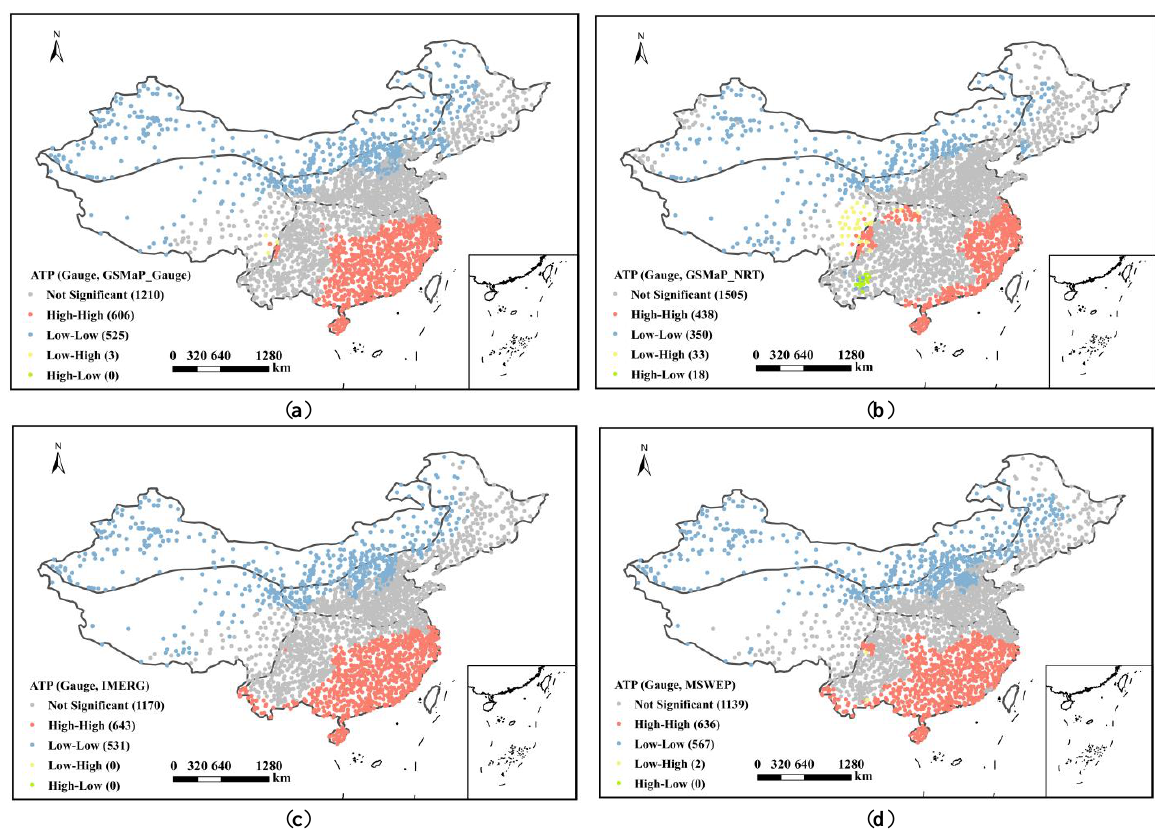
Figure 21. The LISA cluster maps of Box-cox transferred ATP between the gauge observations and the four SPPs and the number in the bracket represent the corresponding number of gauges: ( a ) GSMaP_Gauge, ( b ) GSMaP_NRT, ( c ) IMERG, and ( d ) MSWEP. nstructions or products referred to in the content.